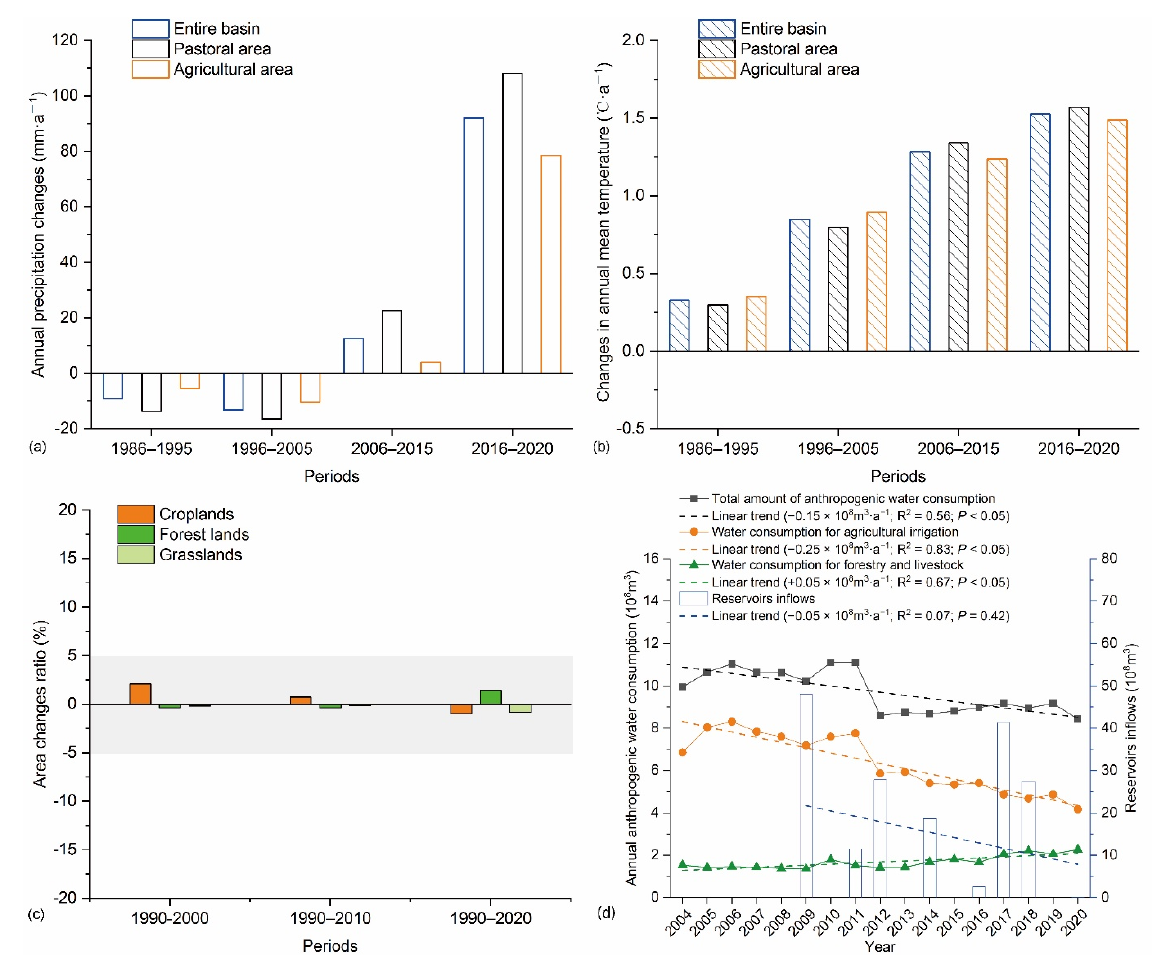
Figure 5. Changes in climate, land-use and anthropogenic water consumption during 1986–2020. Changes in ( a ) annual precipitation and ( b ) annual mean temperature in different periods compared with that in the baseline period (1965–1985). ( c ) Land-use change from 1990 to 2020. ( d ) Annual anthropogenic water consumption from 2004 to 2020, and annual inflows of reservoirs built in the agricultural area from 2009 to 2020.